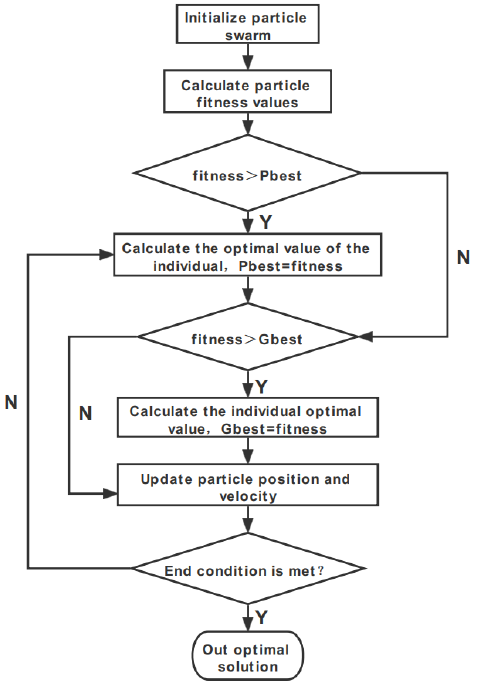
Figure 6. Flow chart of particle swarm optimization.